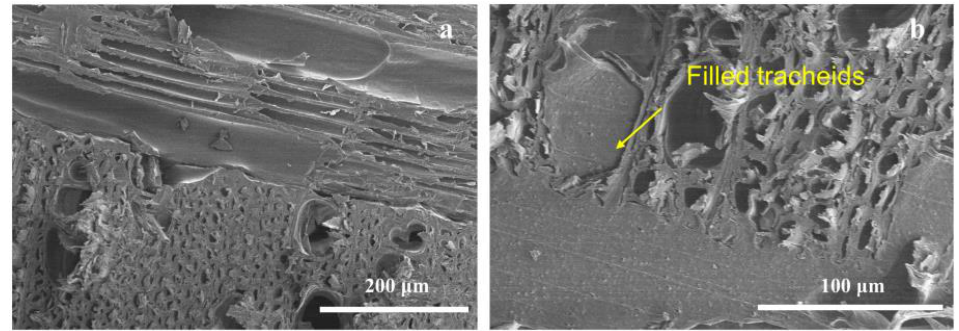
Figure 4. Interfacial SEM micrograph of the VPC made from HDPE: ( a ) without coupling agent; ( b ) with MDI as the coupling agent.